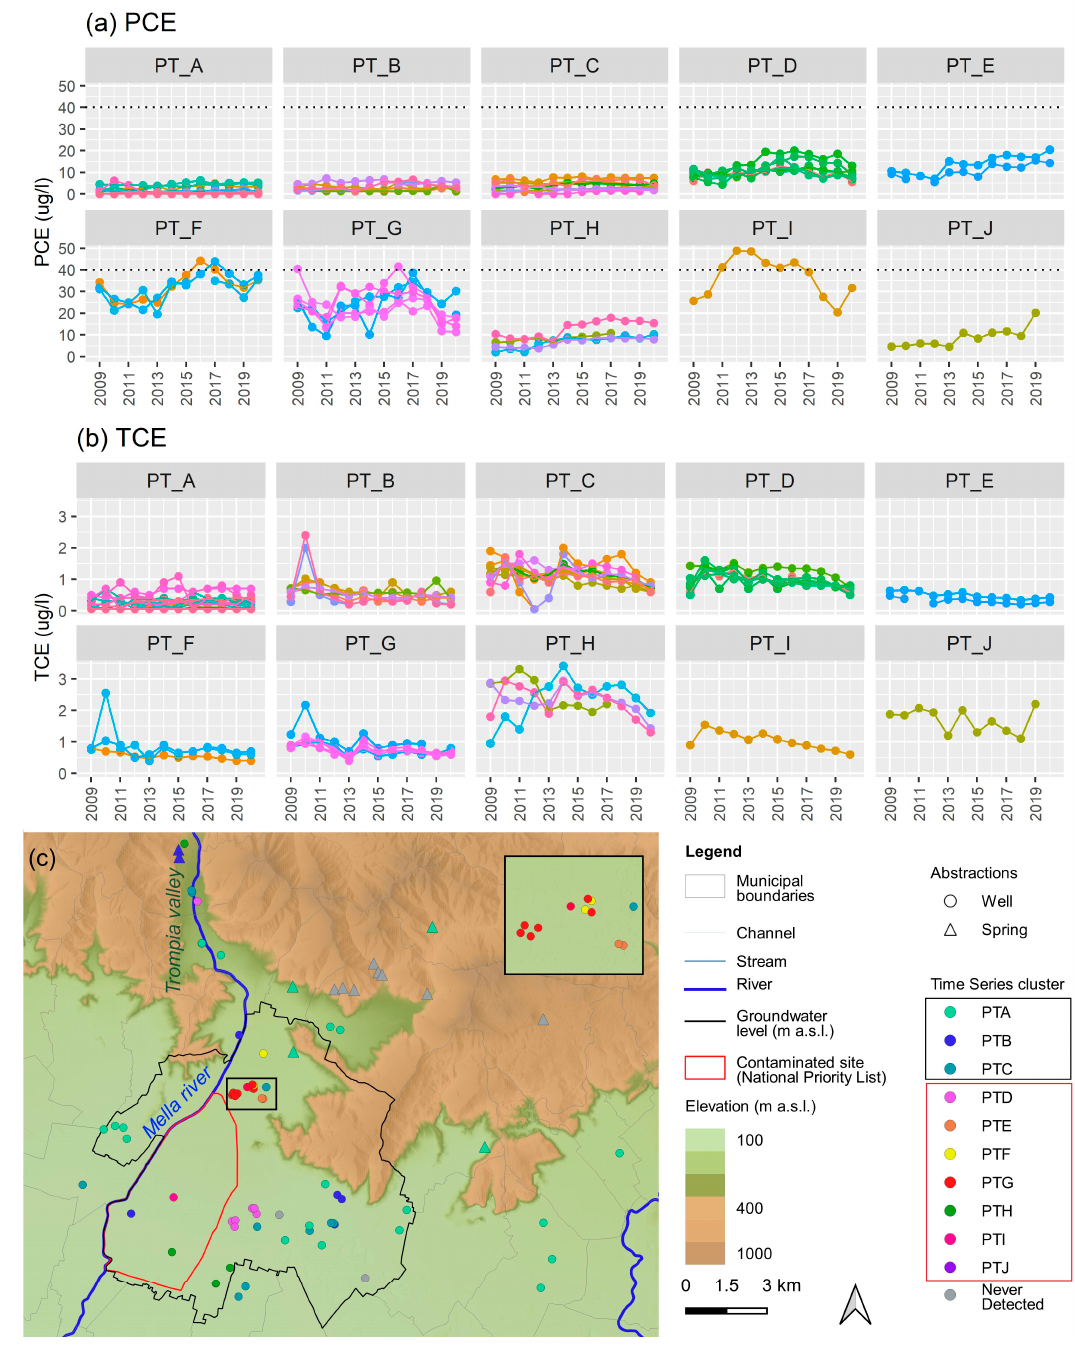
Figure 4. Results of multivariate time series cluster analysis on PCE and TCE: ( a ) PCE time profile of the clusters (dashed lines indicate WHO guide value for PCE in drinking water), ( b ) TCE time profile of the clusters (the WHO guide value for TCE is 20 μ g/L, outside the range of the graphs) and ( c ) spatial distribution of the clusters, black rectangle in the legend indicates clusters associated with diffuse background contamination, while red rectangle indicates clusters associated with local